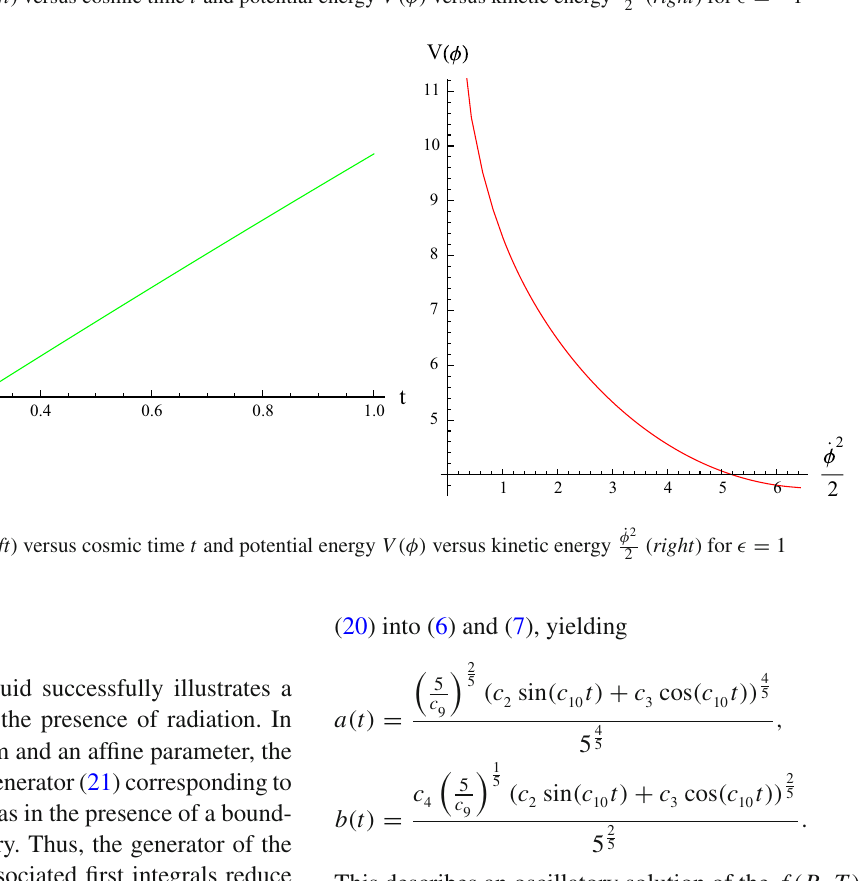
Fig. 3 Plots of scalar field φ( t ) ( left ) versus cosmic time t and potential energy V (φ) versus kinetic energy